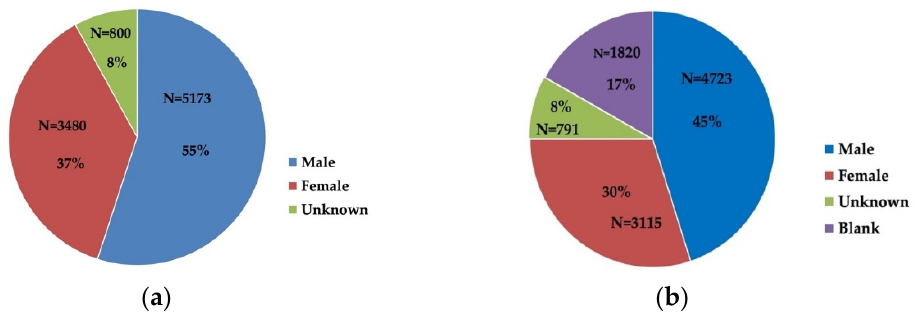
Figure 5. ( a ) Gender of 2019 Animal Cruelty Offenders (%) from the FBI Website; ( b ) Gender of 2019 Animal Cruelty Offenders (%) from CJIS data.